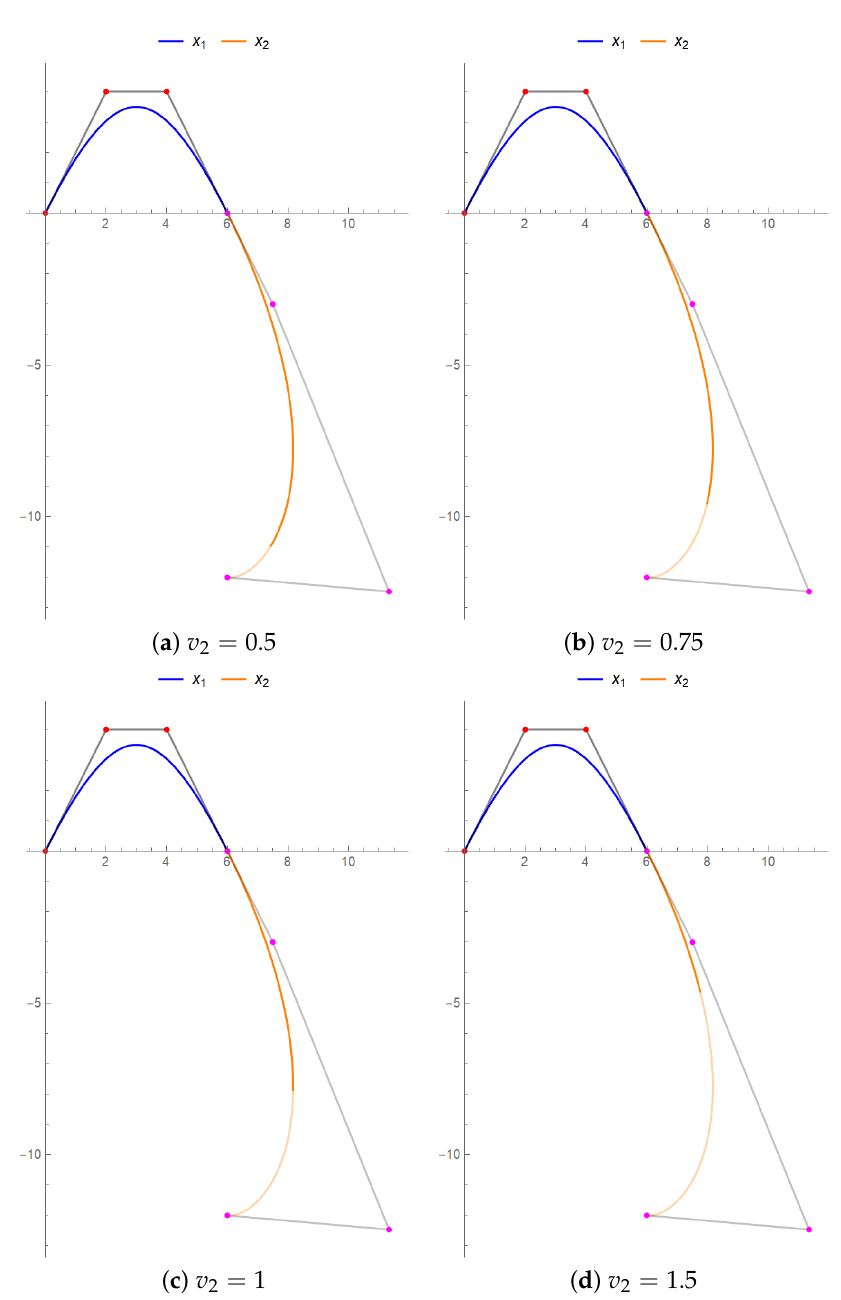
Figure 12. G 2 continuity of two cubic fractional Bézier curves with α and β as scaling factors. The solid blue line represents x 1 , while solid orange line represents x 2 in Figures 11 and 12. Thus, G 2 continuity is much smoother than G 1 continuity by